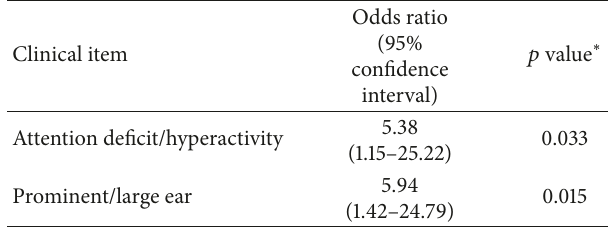
Table 2: Odds ratio showing the effect of clinical items in the 5-item clinical checklist on the likelihood that boys were diagnosed before 8 years old. Clinical items with no statistic difference ( 𝑝 value > 0.05) are not